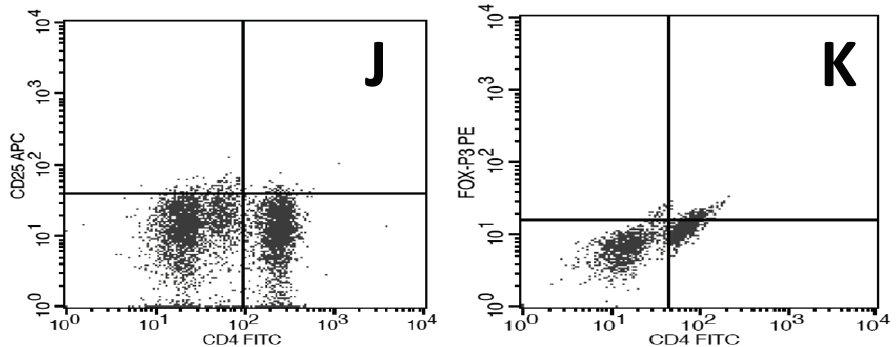
Figure 3. Representative the strategy for FACS analysis and a representative FACS figure. ( A ) The gate was determined for localization of cells corresponding to lymphocytes by for relative size (Forward Scatter, FSC) and granularity/complexity (Side Scatter, SSC) in each experiment and for each patient; ( B – K ) representative graphic obtained from one patient according with antibodies used, illustrating the positive cells: ( B ) CD4 + IL-2 +